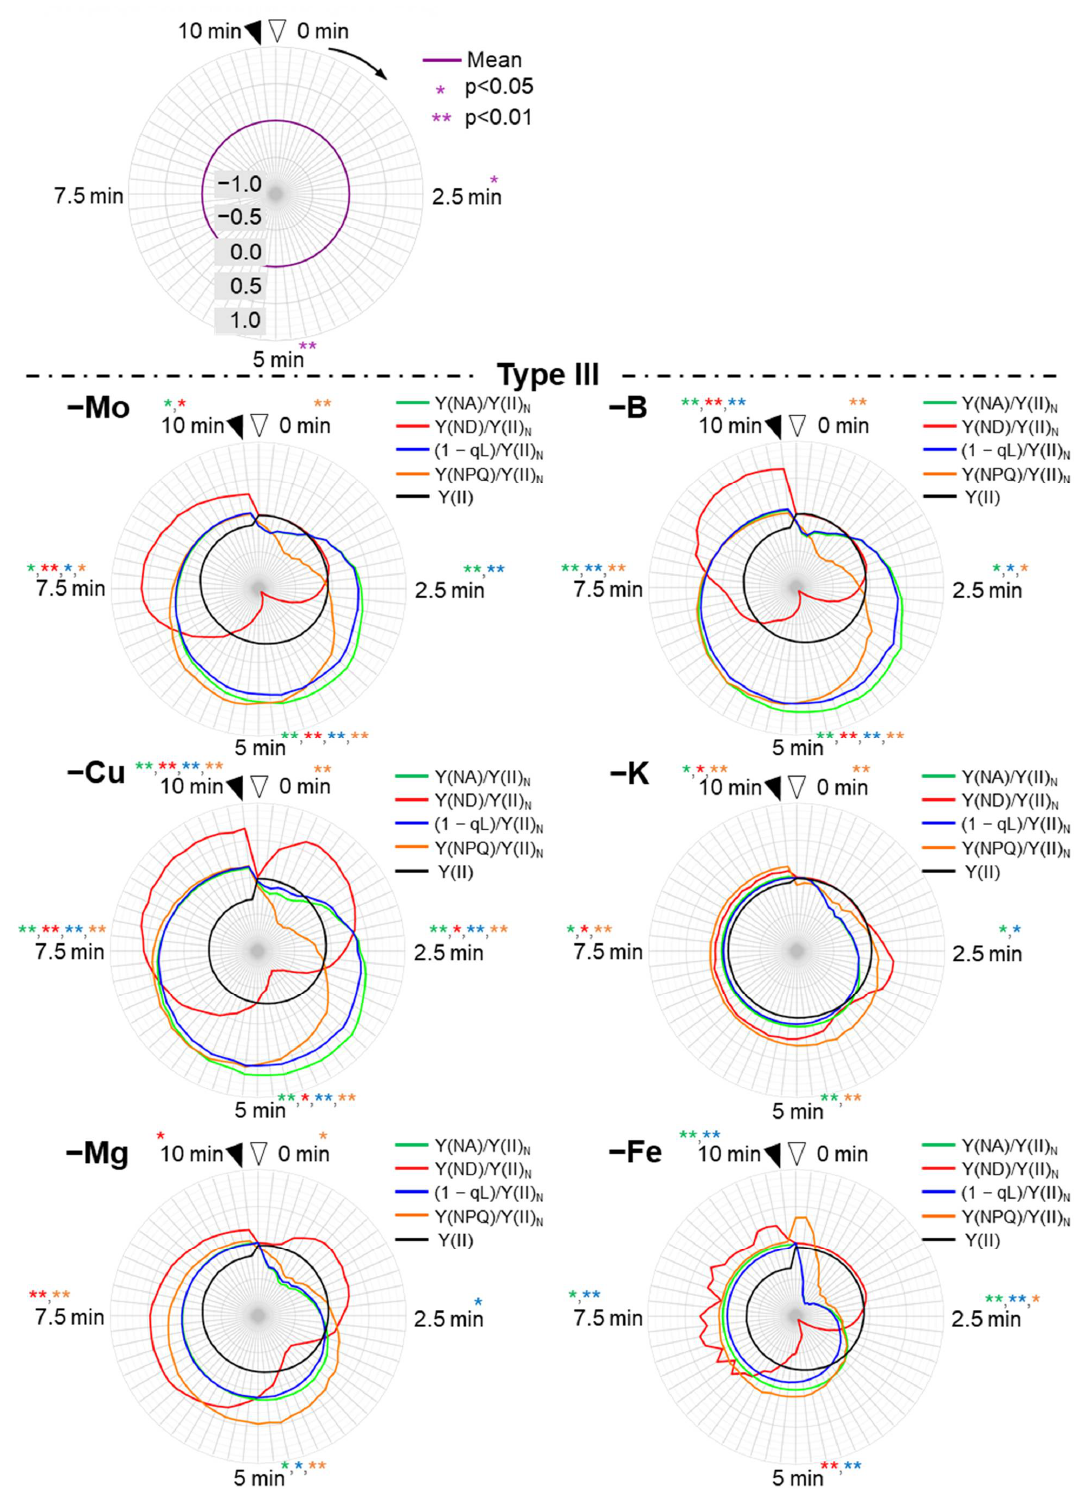
Figure 6. Effects of nutrient-deficiency treatments on the photosynthesis parameters of PSI and PSII in the intact leaves of sunflower plants ( Helianthus annuus ). Data were calculated from Figure 4. The parameters [Y(NA)/Y(II) N , green; Y(ND)/Y(II) N , red; (1 − qL)/Y(II) N , blue; Y(NPQ)/Y(II) N , yellow; Y(II), black] were the differences between the control and the nutrient deficiency (difference normalized plots). Nutrient-deficiency treatments were as follows: Type-I: nitrogen deficiency (–N); phosphate deficiency (–P). Type-II: calcium deficiency (–Ca); zinc deficiency (–Zn); sulfur deficiency (–S); manganese deficiency. Type-III: molybdenum deficiency (–Mo); cupper deficiency (–Cu); magnesium deficiency (–Mg); boron deficiency (–B); potassium deficiency (–K); iron deficiency (–Fe). Data were the differences in the mean between the control plot and each